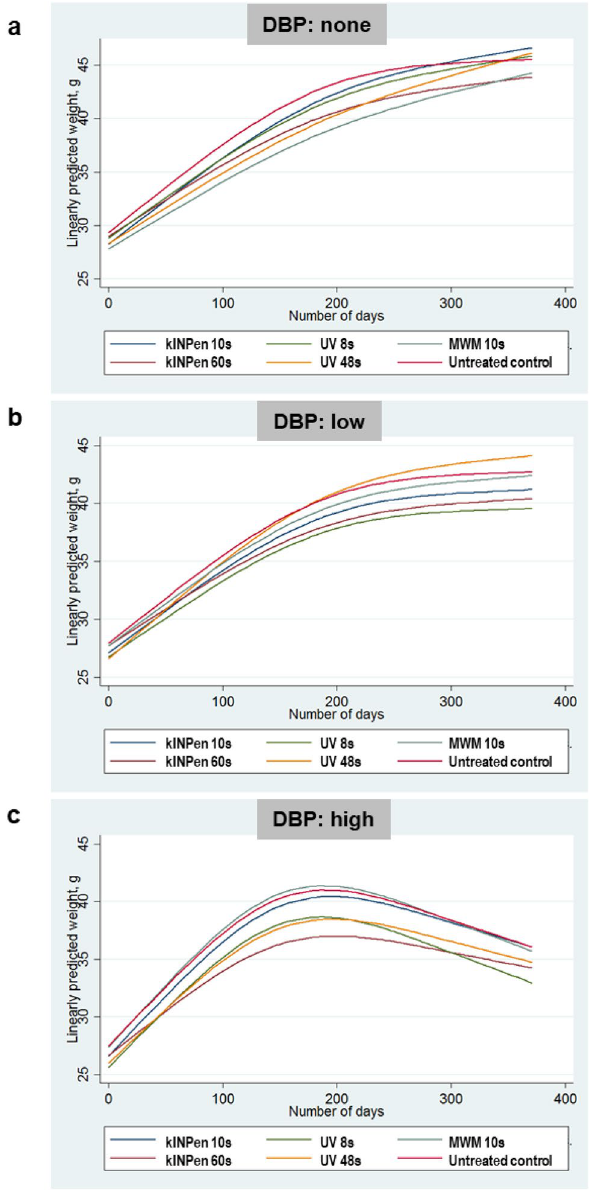
Figure 2. Animal weight gain. ( a – c ) Fitted animal weights across the 1-year observation period for the groups not receiving the co-carcinogenic substance dibenzo(a)pyrene (DBP) ( a ) as well as the groups receiving low ( b ) and high ( c ) doses of